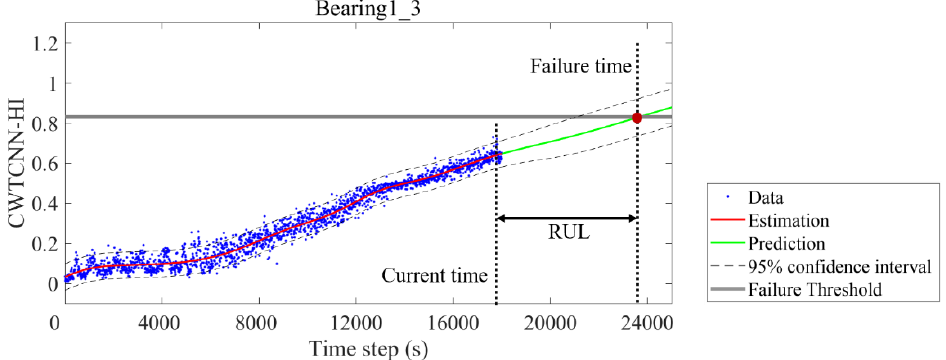
Figure 9. RUL prediction result of bearing1_3.